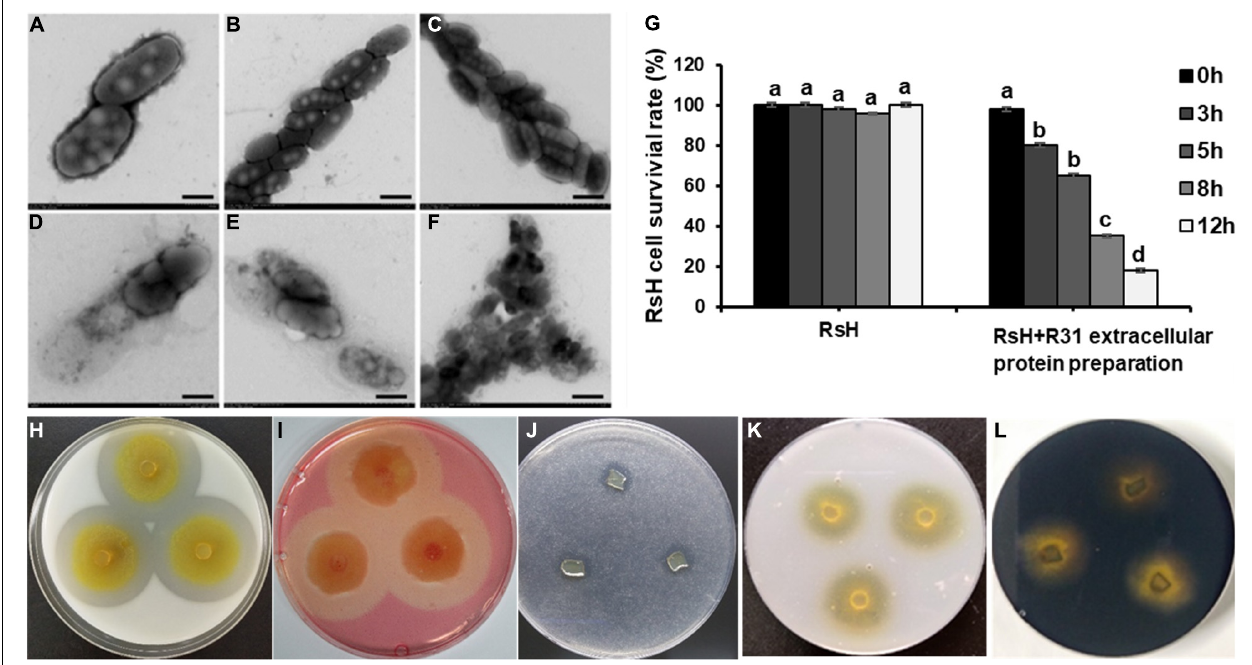
FIGURE 6 | Lysis of RsH by strain R31 extracellular proteins and assay of strain R31 degradation of various polymers. TEM micrograph of RsH cell after treatment with PBS buffer control (A–C) and extracellular proteins (D–F) . Scar bar = 50 nm for panels (A,D) , scar bar = 1 µ m for panels (B,C,E,F) . (G) Statistical analysis of cell viability of RsH treated with strain R31 extracellular proteins at different times. Error bars represent standard errors ( ± SD) from three repeated experiments. Duncan multiple comparison test ( p < 0.05) was performed on the data, the same letter means no difference, and different letters mean there is a difference. For panels (H–L) , skimmed milk (H) , sodium carboxymethyl cellulose (I) , tributyrin (J) , colloidal chitin (K) and starch (L) were each added to CTT plate at a final concentration of 0.5%. The exponential culture of strain R31 was spotted and incubated at 30 ◦ C. After 4 days of incubation, the plates were photographed. Triplicated experiments were performed for each test, and the representative images are